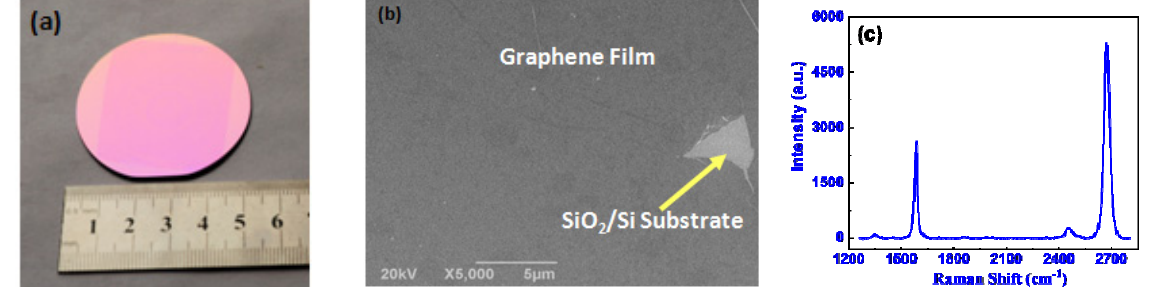
Figure 1. The photo of large-area graphene film transferred onto 2 inch SiO 2 /Si substrate ( a ), SEM image ( b ) and the Raman spectrum of the graphene film ( b ).